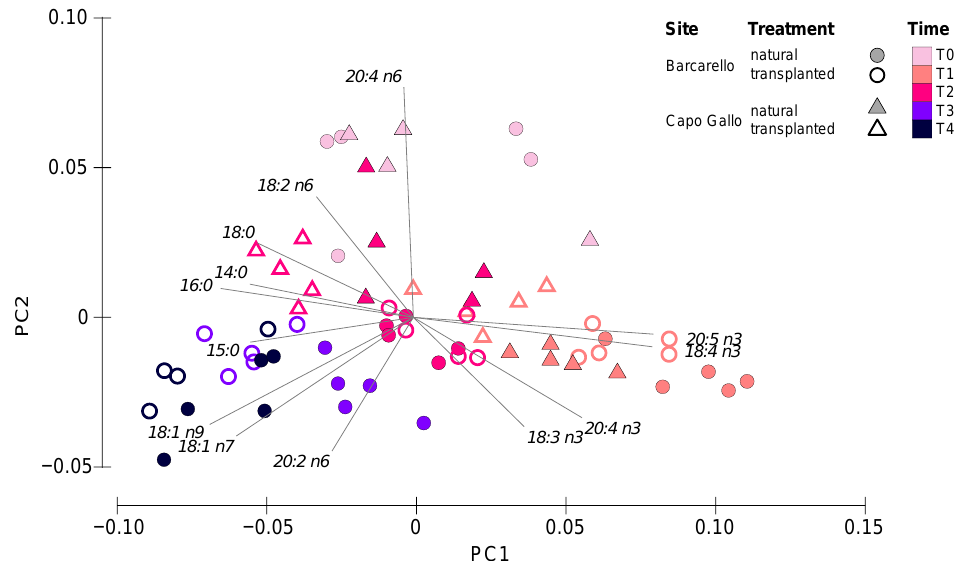
Figure 4. Principal component analysis (PCA) of fatty acid profiles for both natural and transplanted Ericaria amentacea thalli throughout the experiment at Barcarello and Capo Gallo sites. Table 3. SIMPER analysis showing fatty acids of Ericaria amentacea thalli that contribute most to the dissimilarity between times at each site and